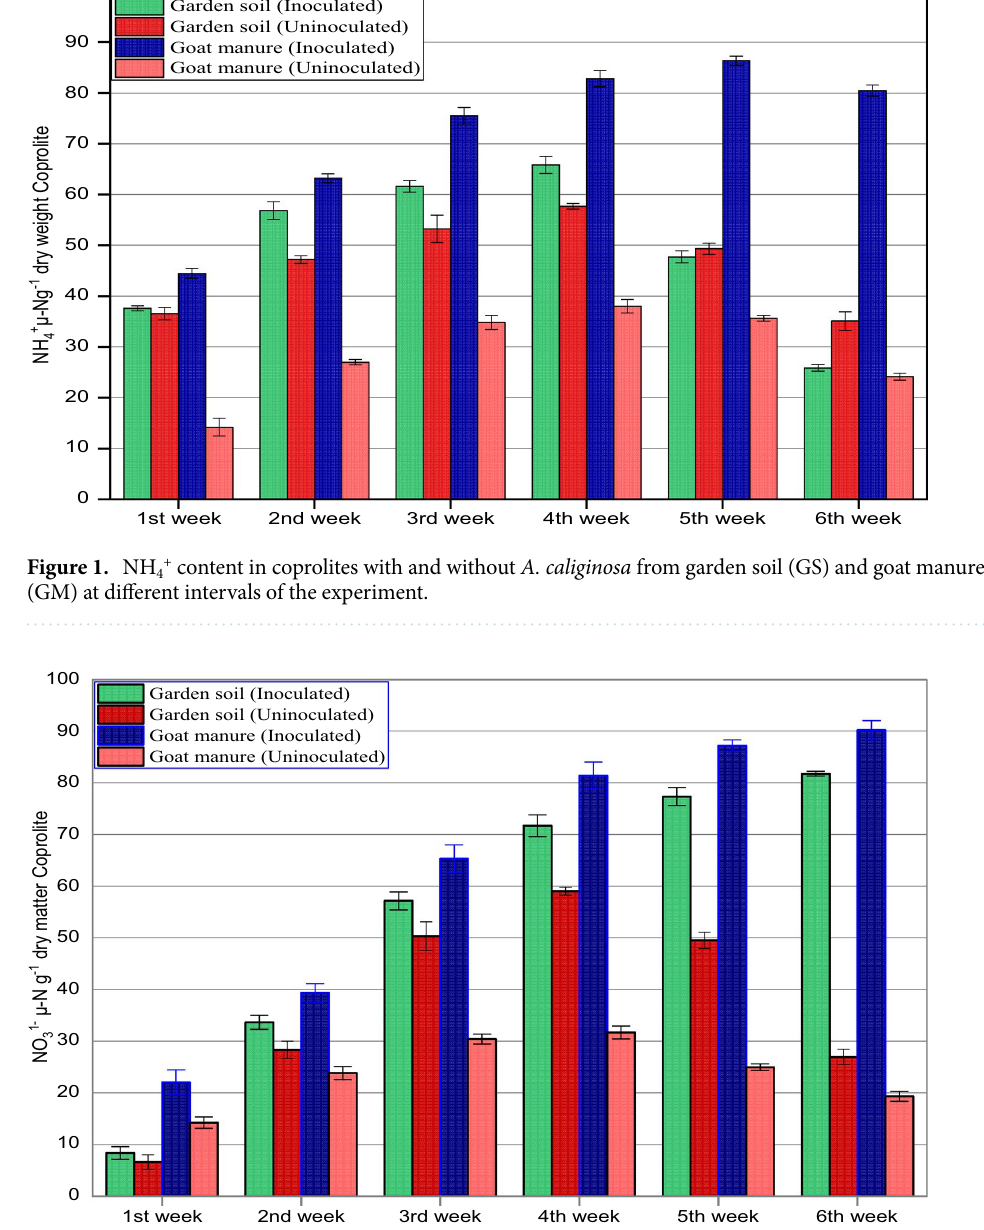
Figure 2. NO 3− content in coprolites with and without A. caliginosa from garden soil (GS) and goat manure (GM) at different intervals of the